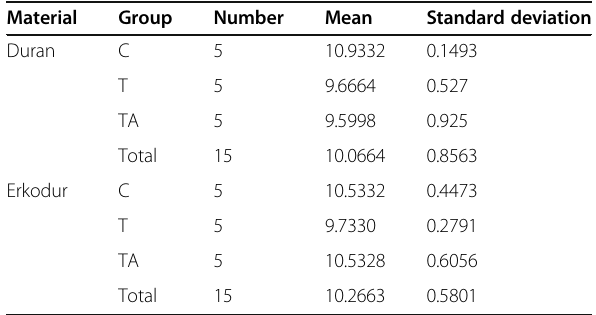
Table 2 Descriptive analysis of hardness (hardness Vickers